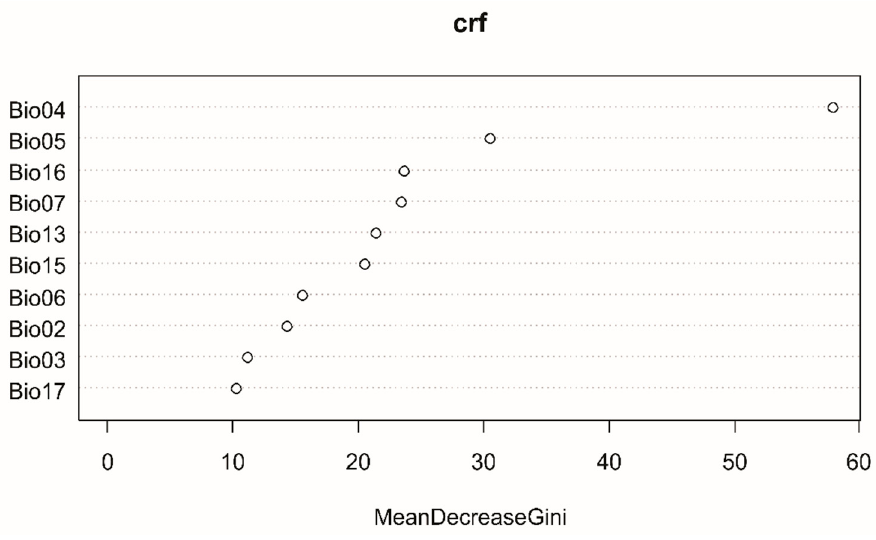
Figure 4. Variable importance in random forest model.